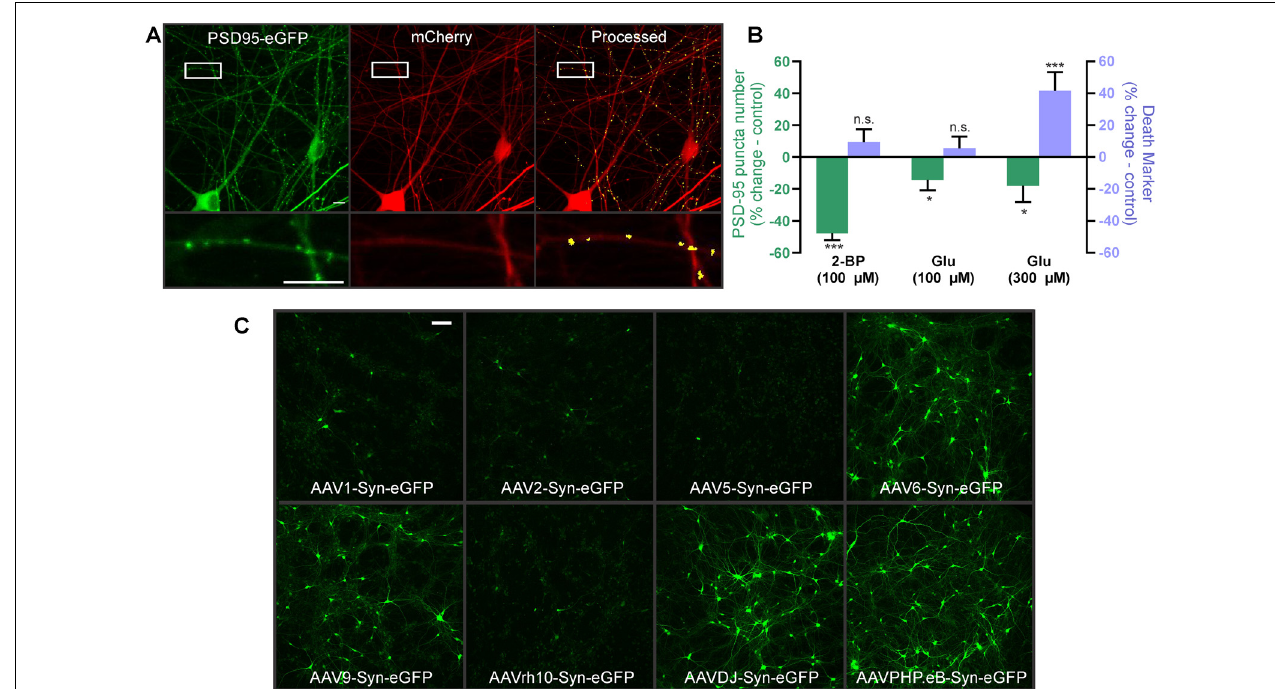
FIGURE 5 | Automated synapse analysis in human induced pluripotent stem cell (iPSC)-derived neuronal cultures. (A) Representative confocal image of human iPSC-derived cortical neurons expressing HdAd-hSyn-PSD95-eGFP-hSyn-mCherry. Expression of the PSD95-eGFP fusion protein produces fluorescent puncta at excitatory synapses (green) and mCherry expression fills the cell and defines its morphology (red). Automated image processing was performed as described in Methods and puncta meeting size and intensity criteria were counted (yellow) and overlaid on the mCherry MIP (processed). Insets display enlarged images of the boxed regions. Scale bar: 10 µ M. (B) Bar graph of change in synapse number (PSD95 puncta) and death marker (red mask particle number) from 0 to 24 h in neurons treated with 100 µ M 2-BP, 100 µ M glutamate, and 300 µ M glutamate compared to respective untreated control wells. Data were collected using wide-field microscopy (nested unpaired t -test; t ( 4 ) = 3.947, p = 0.017 for puncta change, t ( 4 ) = 0.978, p = 0.383 for cell death, n = 36 ROIs from three wells for untreated, n = 35 ROIs from three wells for 100 µ M 2-BP. Nested unpaired t -test; t ( 10 ) = 2.291, p = 0.045 for puncta change, t ( 10 ) = 0.849, p = 0.416 for cell death, n = 71 ROIs from six wells for untreated, n = 71 ROIs from six wells for 100 µ M glutamate. Nested unpaired t -test; t ( 10 ) = 2.277, p = 0.024 for puncta change, t ( 10 ) = 2.214, p = 0.028 for cell death, n = 71 ROIs from six wells for untreated, n = 66 ROIs from six wells for 300 µ M glutamate). ImageJ settings were as follows; Red MIP mask threshold: 0.5 × red MIP mean intensity, Red MIP threshold for particle number: Red MIP mean + 0.25 × SD, Puncta threshold: green MIP mean + 5 × SD, puncta size restriction: 3–30 pixels. Data are expressed as mean ± SEM of each ROI, n.s. = not significant, ∗ p < 0.05, ∗∗∗ p < 0.001 compared to respective untreated control wells. (C) Images representative of three wells show hSyn-driven expression of eGFP in human iPSC-derived cortical neurons transduced with the indicated adeno-associated viruses (AAV) serotypes. Scale bar: 100 µ